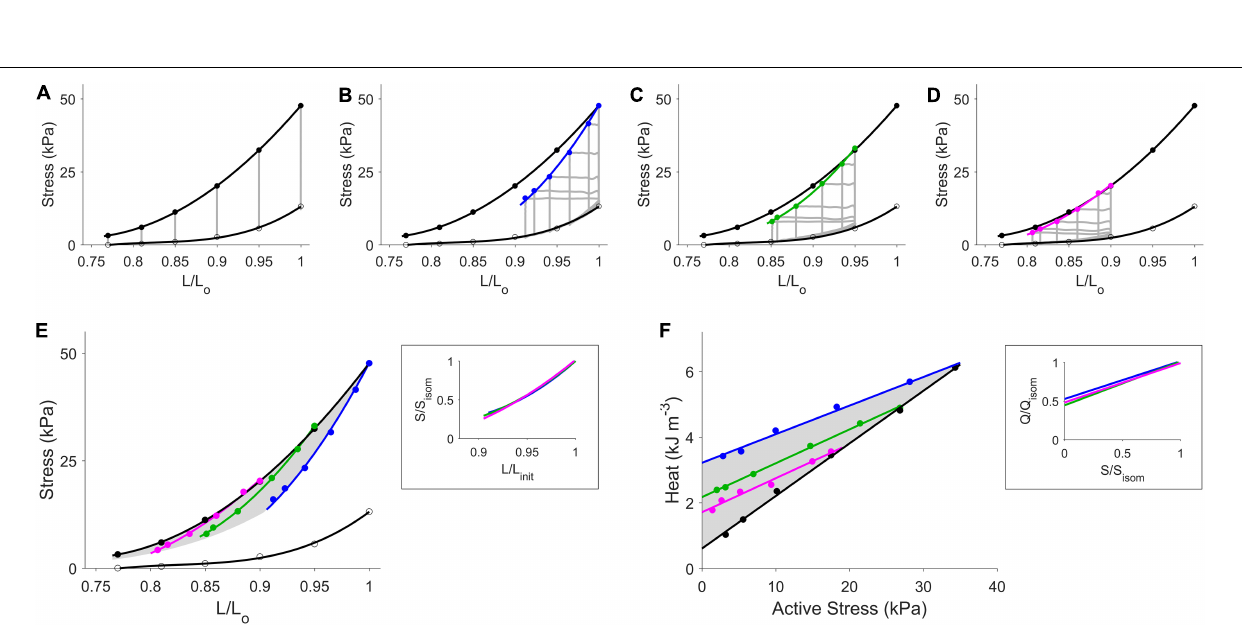
Frontiers in Physiology | www.frontiersin.org